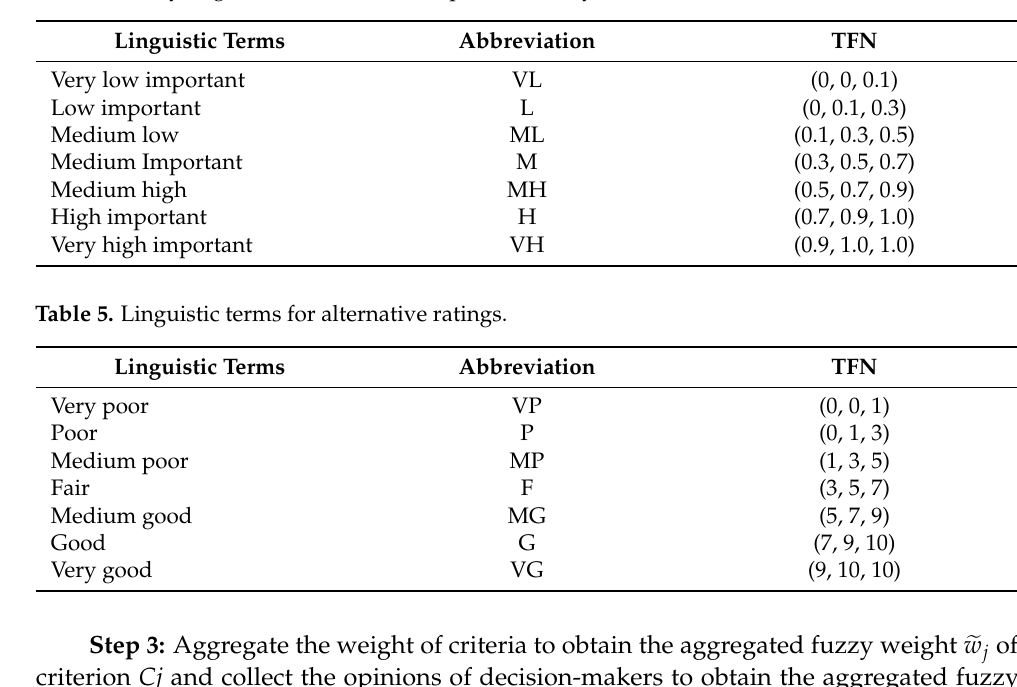
Table 4. Fuzzy linguistic terms and correspondent fuzzy numbers for each criterion.